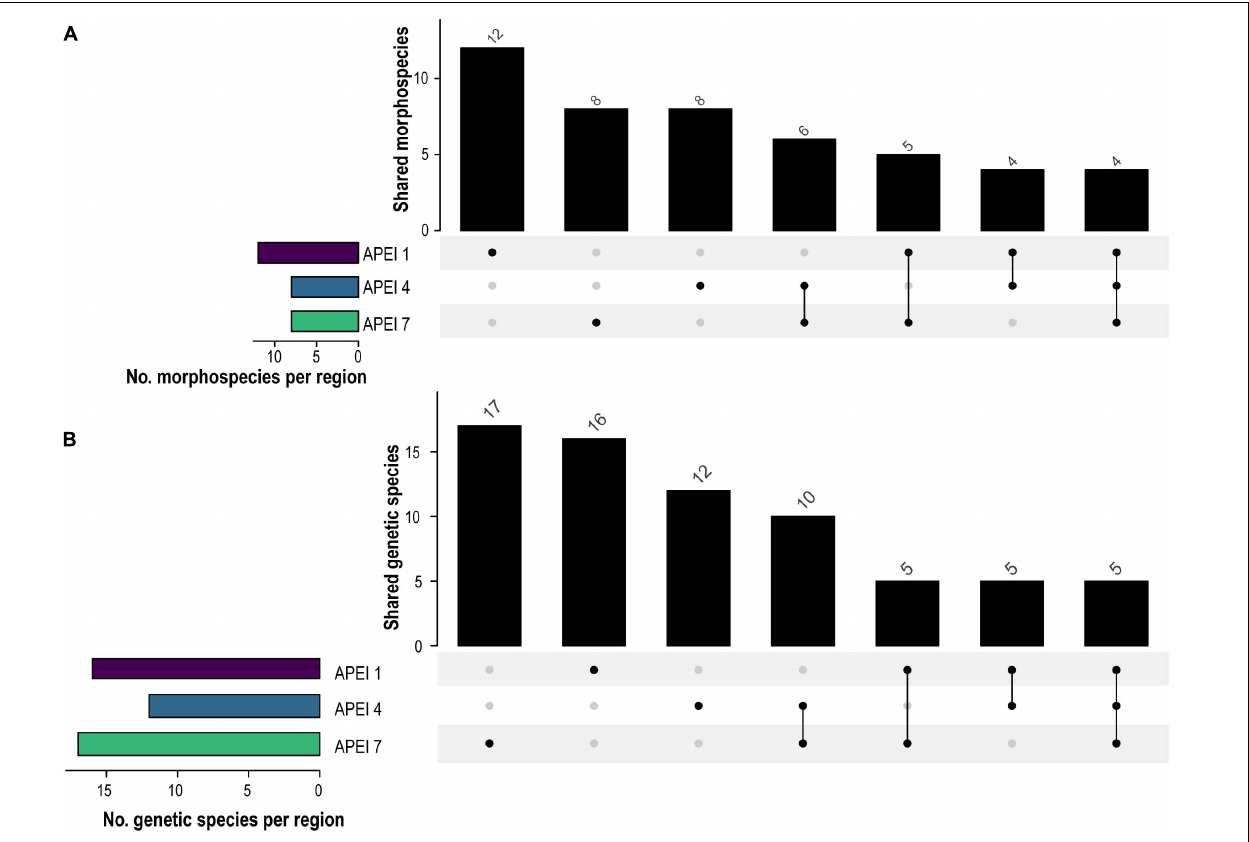
FIGURE 2 | UpSet plots showing shared number of morphospecies (A) and genetic species (B) species between western CCZ APEIs (APEI 1, 4, and 7) in vertical bars and total number of species per site indicated by horizontal